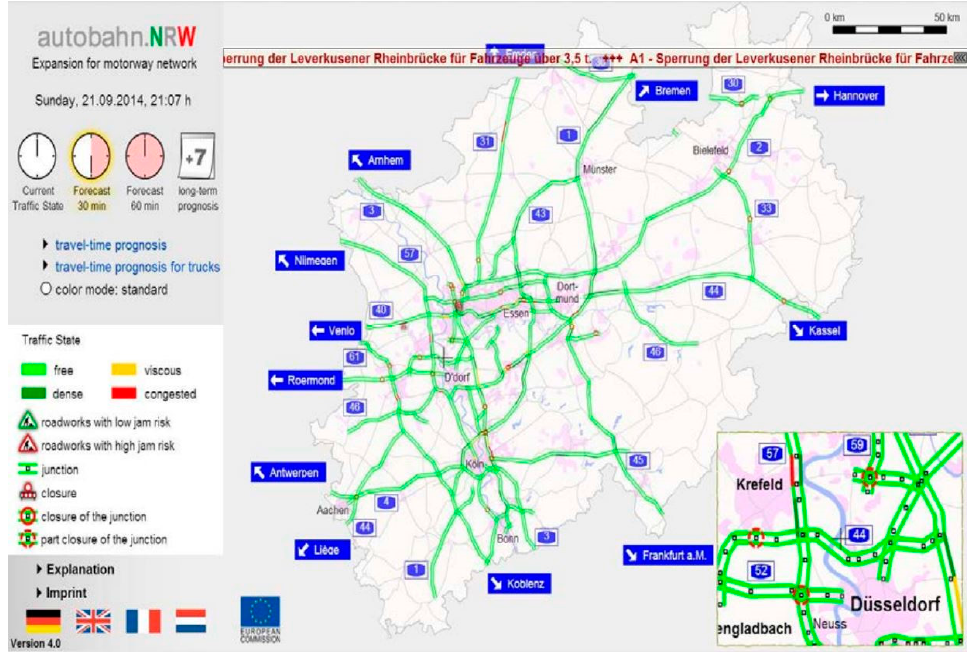
Figure 1. German traffic forecast information system.